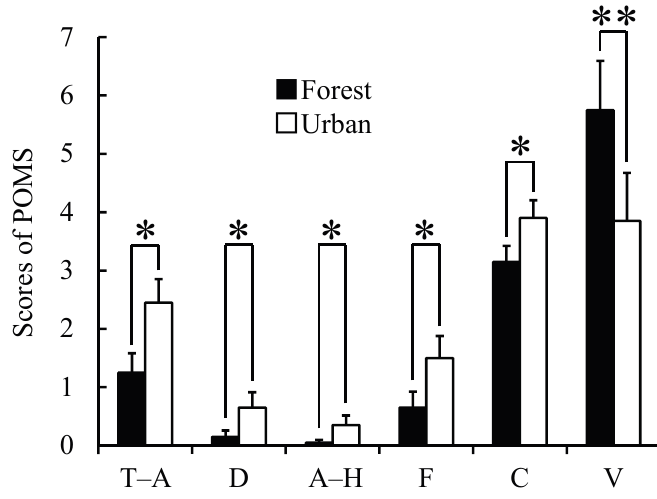
Figure 5. Comparison of Profile of Mood State (POMS) scores between the two environments. T–A: tension–anxiety; D: depression; A–H: anger–hostility; F: fatigue; C: confusion; V: vigor. N = 20, mean ± standard error. * p < 0.05, ** p < 0.01, Wilcoxon signed-rank